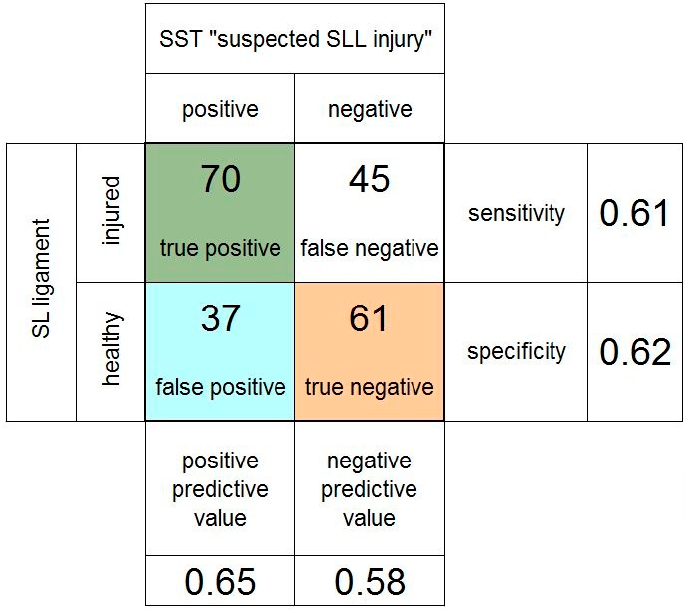
Figure 6. Fourfold table of the scaphoid shift test (SST) in the subgroup of patients referred specifically for suspected scapholunate (SL) ligament injury.